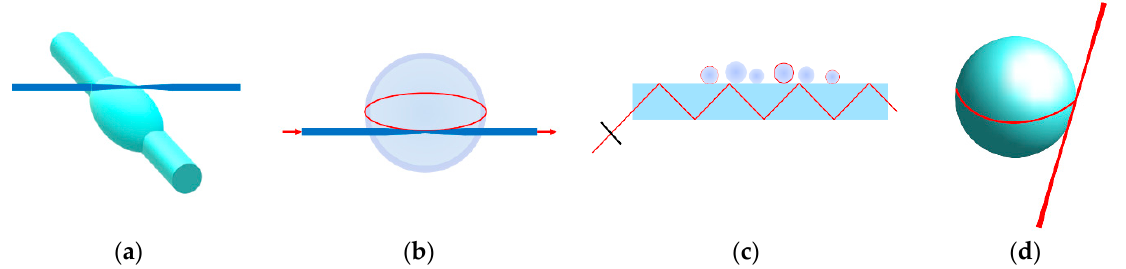
Figure 1. Different types of WGM humidity sensors: ( a ) Microbottle coupled by tapered fiber; ( b ) Microsphere coated with humidity-sensitive layer coupled by tapered fiber; ( c ) Many microspheres coupled by a prism; ( d ) Humidity sensitive liquid droplet resonator coupled by a free space beam.